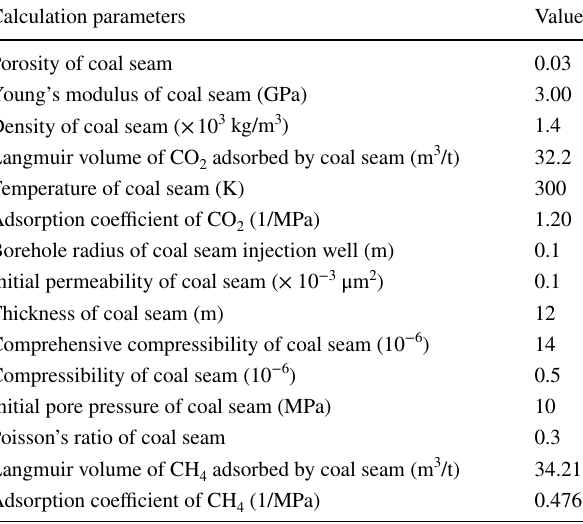
Table 1 Calculation parameters of the coal seam Calculation parameters